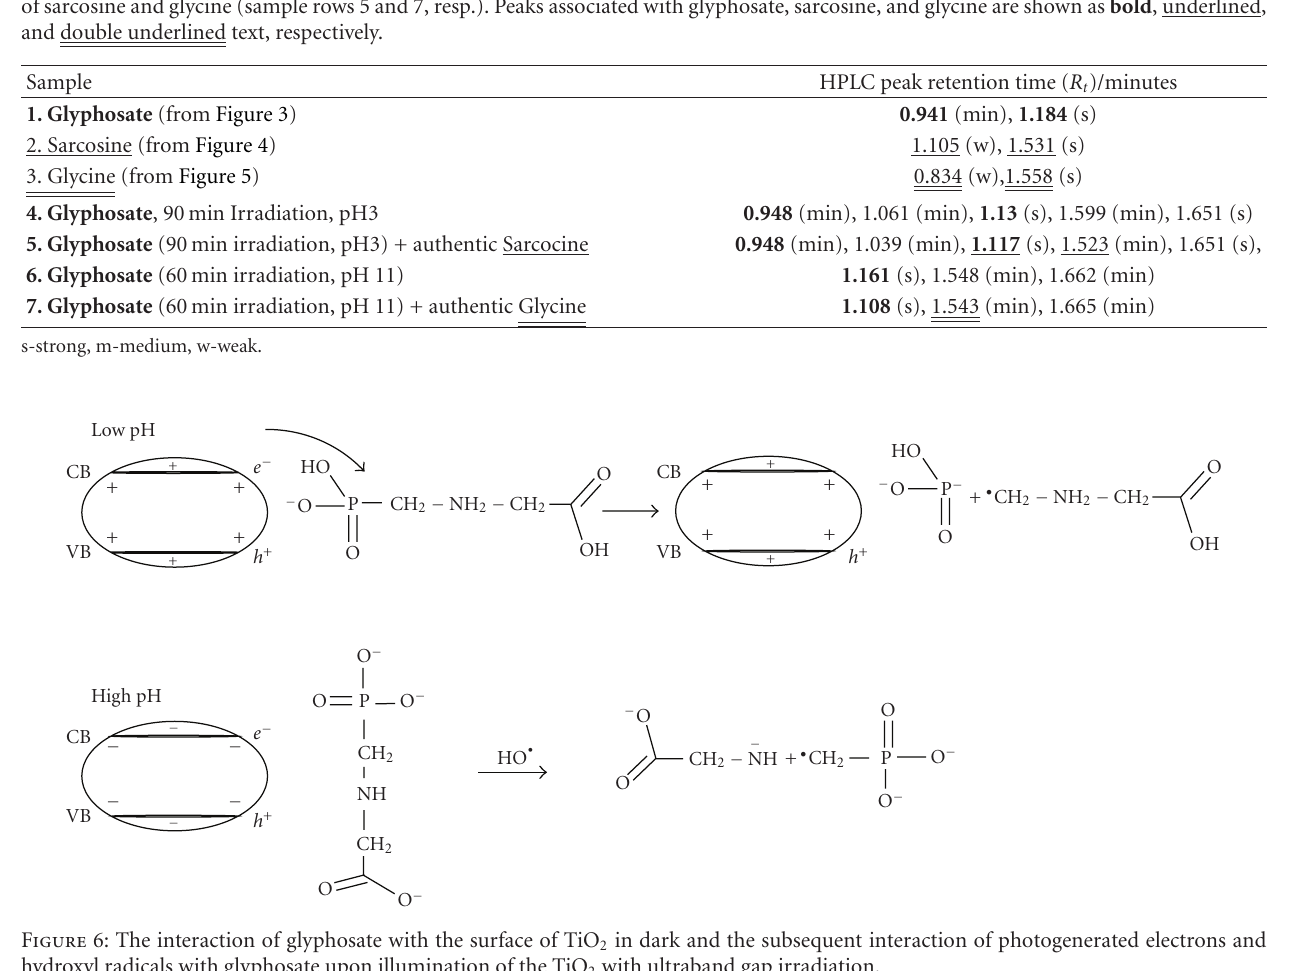
authentic material to photodegraded reaction mixtures,